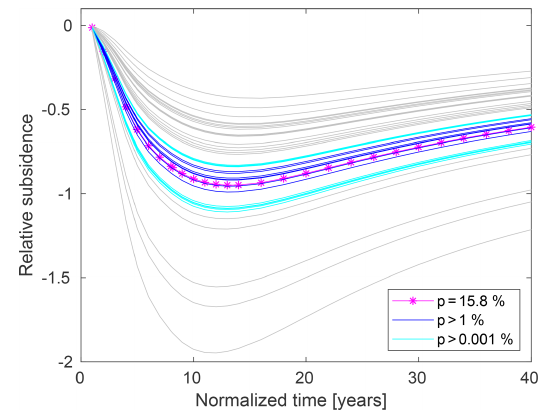
Figure 2. Outcomes of RF for the forecast state ensemble, the third in Table 1. Every realization is colored depending on its probability of occurrence p